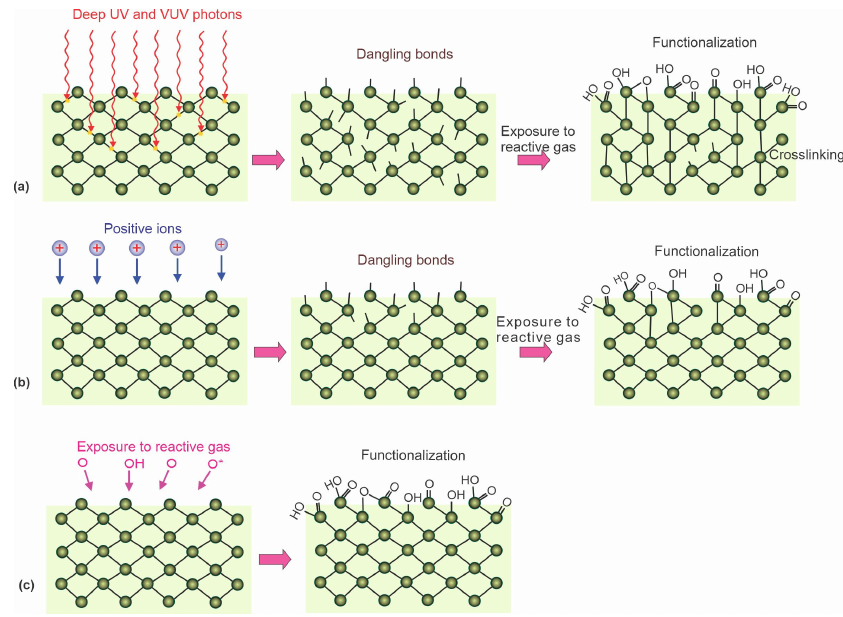
Figure 2. Illustration of the effects of various reactive plasma species: ( a ) energetic photons, ( b ) pos- itively charged ions, ( c ) and neutral oxidizing plasma species on the surface finish of polymers.